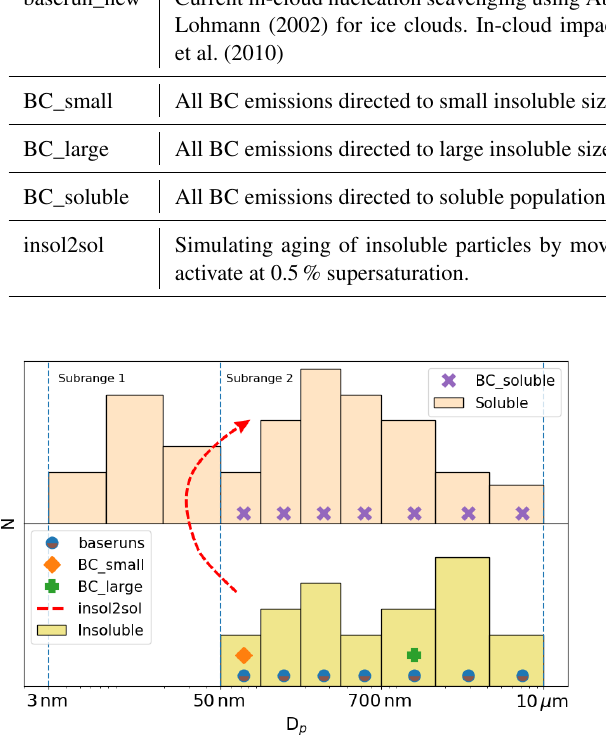
Figure 1. Schematic representation of the number size distribution, ( N ), of aerosols in different simulations as a function of diameter D p